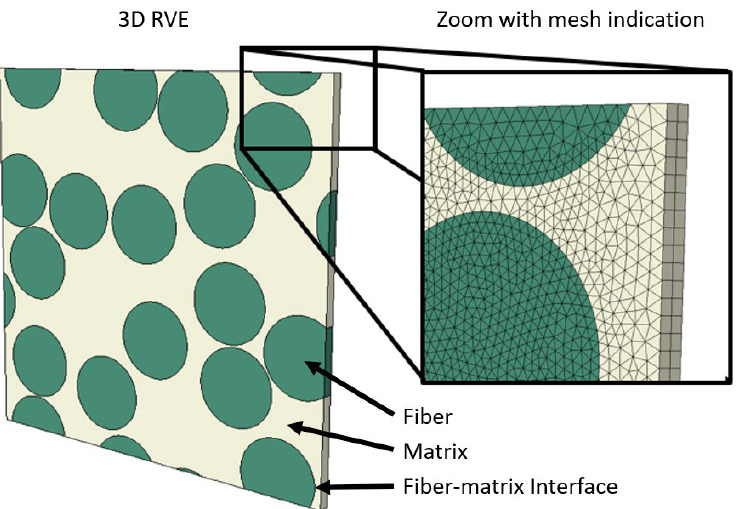
Figure 1. Periodic RVE with 16 fibers and a fiber volume fraction of 50%.